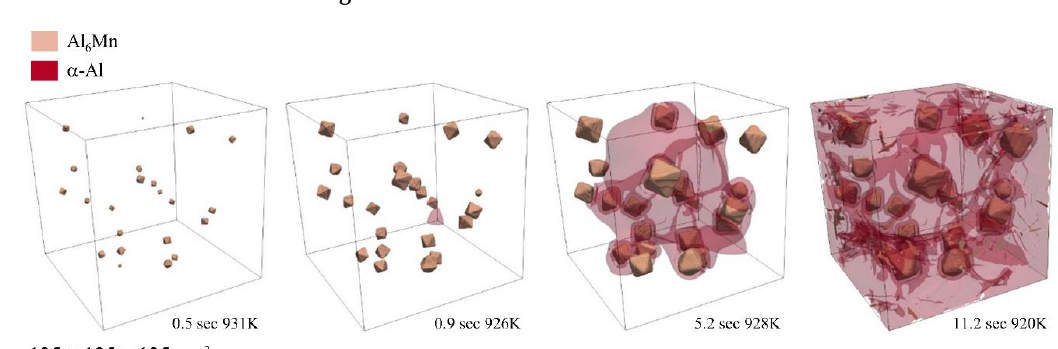
Figure 7. 3D simulated microstructural evolution.